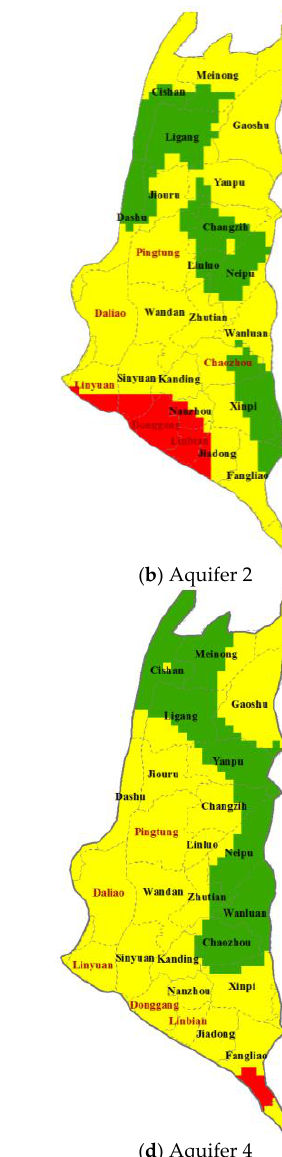
Figure 7. Spatial distribution of estimated target cancer risk (TR). The TR values are classified as <10 −6 , 10 −6 –10 −5 , 10 −5 –10 −4 and >10 −4 .